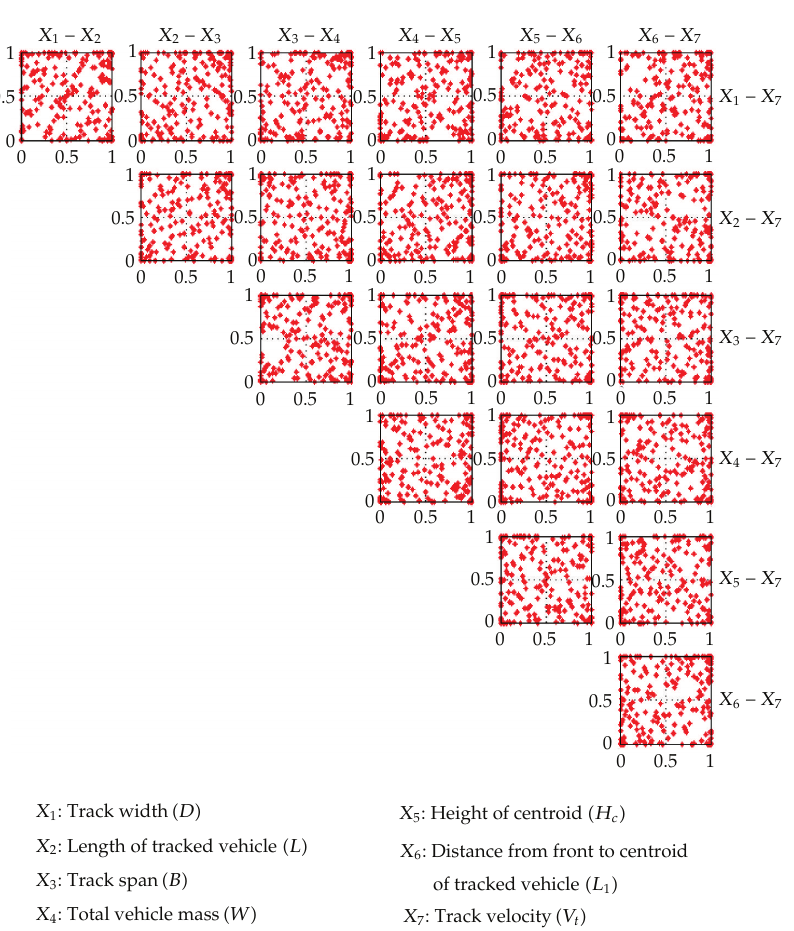
Figure 5: Projection plots of 180 sample points in normalized space for crawler kriging